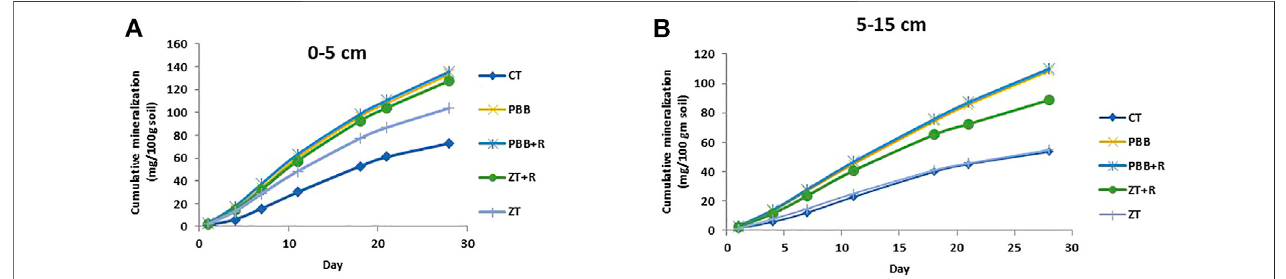
FIGURE 3 | Cumulative carbon mineralization affected by different CA practices (A) 0 – 5 cm (B) 5 – 15 cm soil